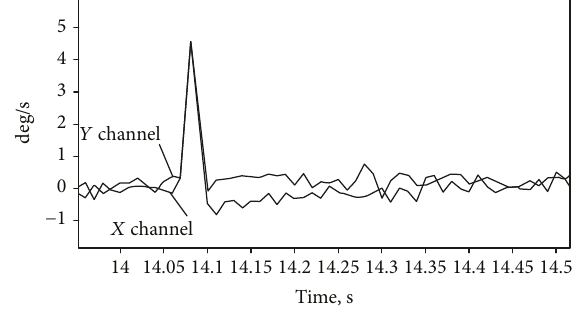
Figure 3: X and Y channel responses to small